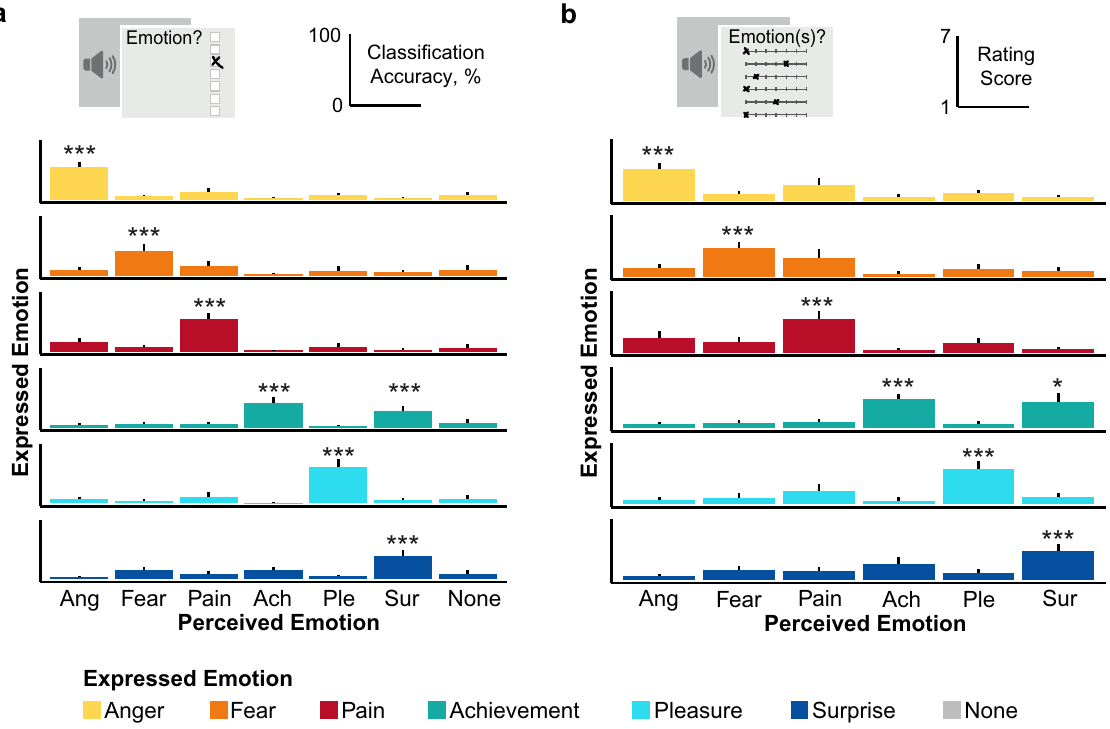
Figure 2. Emotion classification and rating patterns for each expressed emotion. ( a ) The main diagonal represents ‘correct’ emotion classification. The most common confusion is between achievement and surprise. Interestingly, this confusion is not perfectly symmetrical, as surprise, when misclassified, is as likely to be categorized as achievement or fear. ( b ) Average ratings on matching scales are higher than ratings on other scales. Scores on scales of matching valence are depicted in the upper left corner (negative) and the lower right corner (positive). Error bars indicate 95% confidence intervals. Ach Achievement, Ang anger, Ple pleasure, Sur surprise. * p < 0.05. *** p < 0.001. Figure created with R version 4.0.3 35